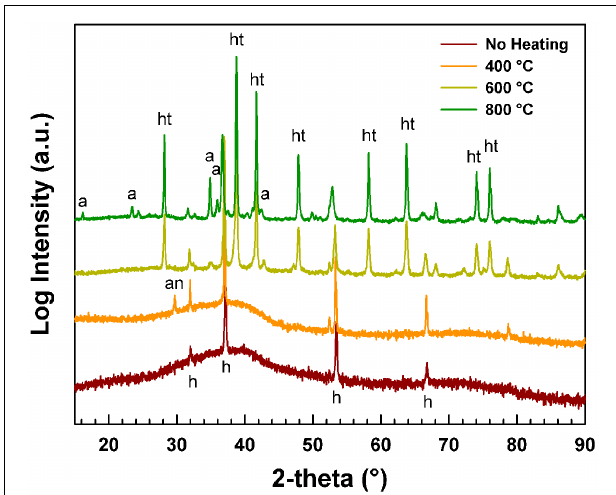
FIGURE 9 | X-ray diffraction pattern of Loihi sample before and after thermal treatment. The pattern obtained with no heat treatment and treatment at 400˚C have only two broad lines similar to the pattern of material without treatment. In the 600 and 800˚C treatments, the sharp lines correspond to hematite and the broad lines of Fh are no longer present. Aegerine “a,” anhydrite “an,” hematite “ht,” and halite “h.”